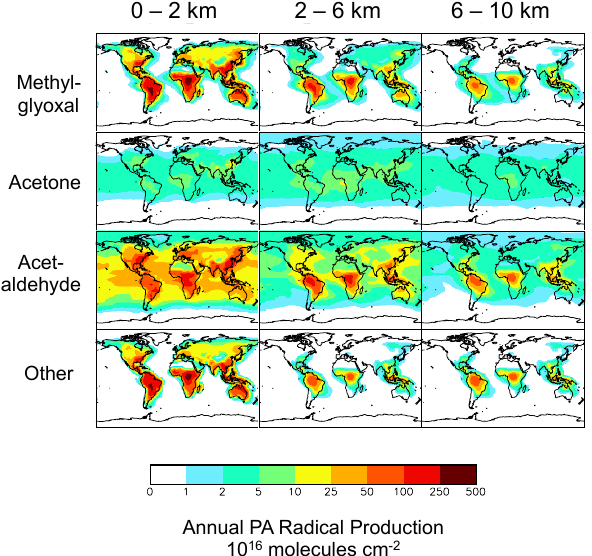
Fig. 6. Annual total PA radical production for three altitude ranges contributed by the immediate precursors methylglyoxal, acetone, and acetaldehyde. The other precursors include a number of species produced in the oxidation of isoprene.